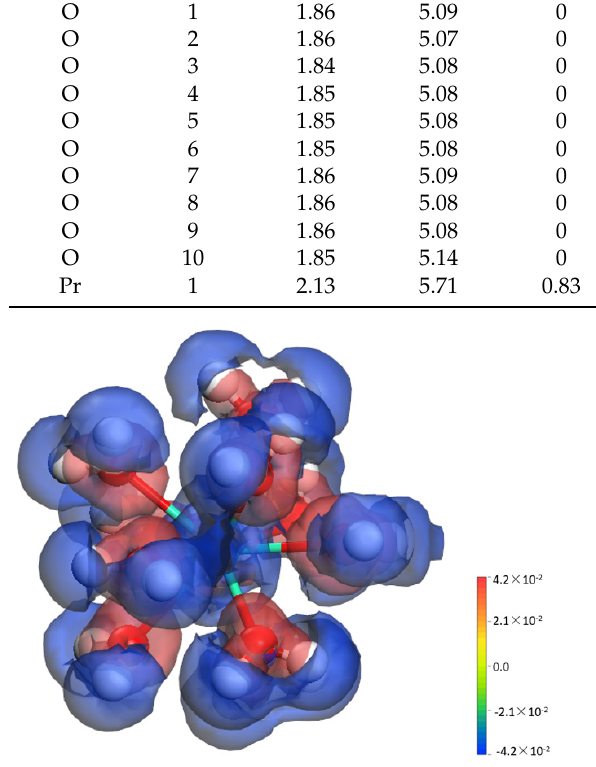
Figure 2. The difference charge density of [Pr(H 2 O) 10 ] 3+ . 3.2. [Pr(H 2 O) n ] 3+ Adsorbed on the (001) Surface of